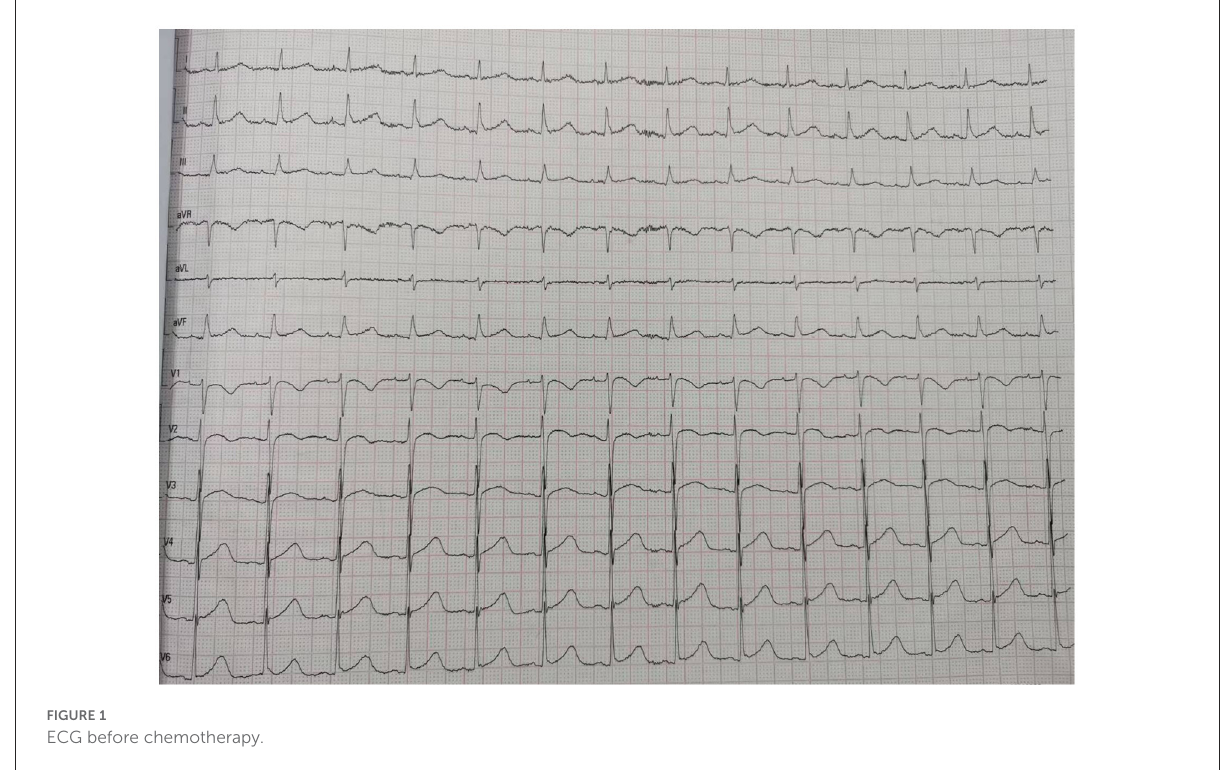
FIGURE1 ECG before chemotherapy.